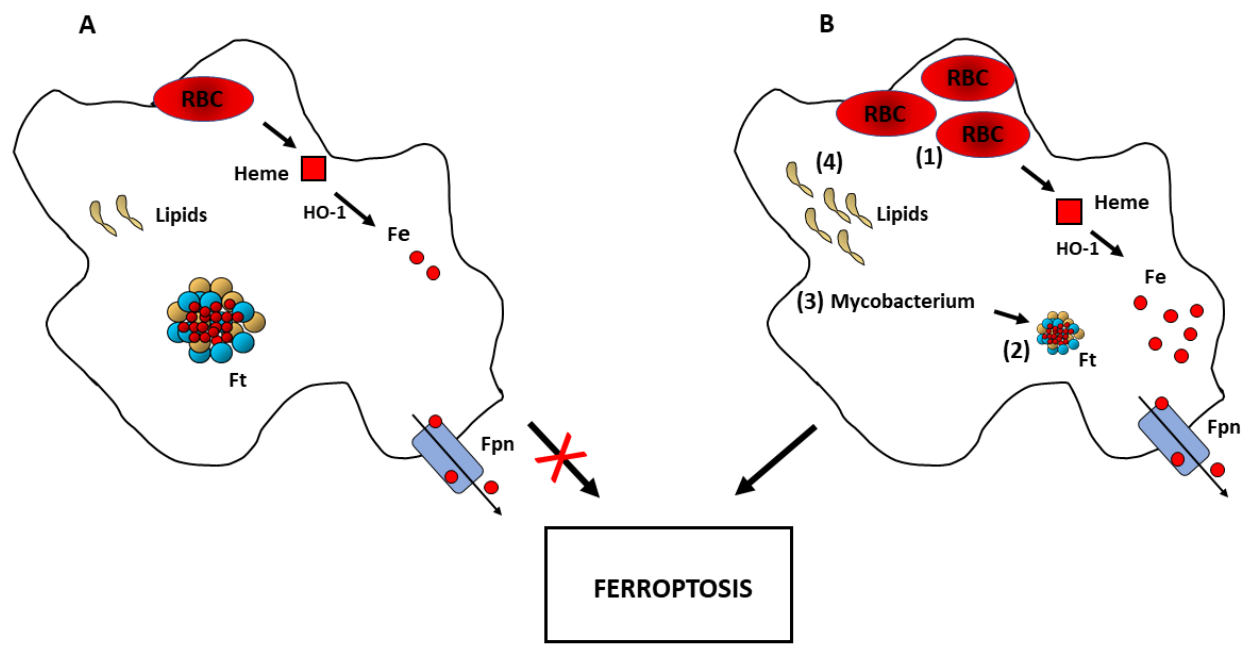
Figure 2. Macrophages and ferroptosis. ( A ) The low sensitivity of macrophages to ferroptosis under conditions of physiological RBC ingestion depends on efficient expression of HO-1, ferritin and ferroportin, which protect the cell from heme and iron load. ( B ) These homeostatic defense mechanisms are not sufficient to prevent ferroptosis in case of increased iron content caused by excessive erythrophagocytosis (1) or ferritin degradation (ferritinophagy) (2) triggered for example by Mycobacterium tuberculosis infection (3). Considering the role of polyunsaturated fatty acids in ferroptosis, an excess of lipids can also facilitate ferroptosis of iron loaded macrophages, for example in the context of atherosclerotic plaques (4).